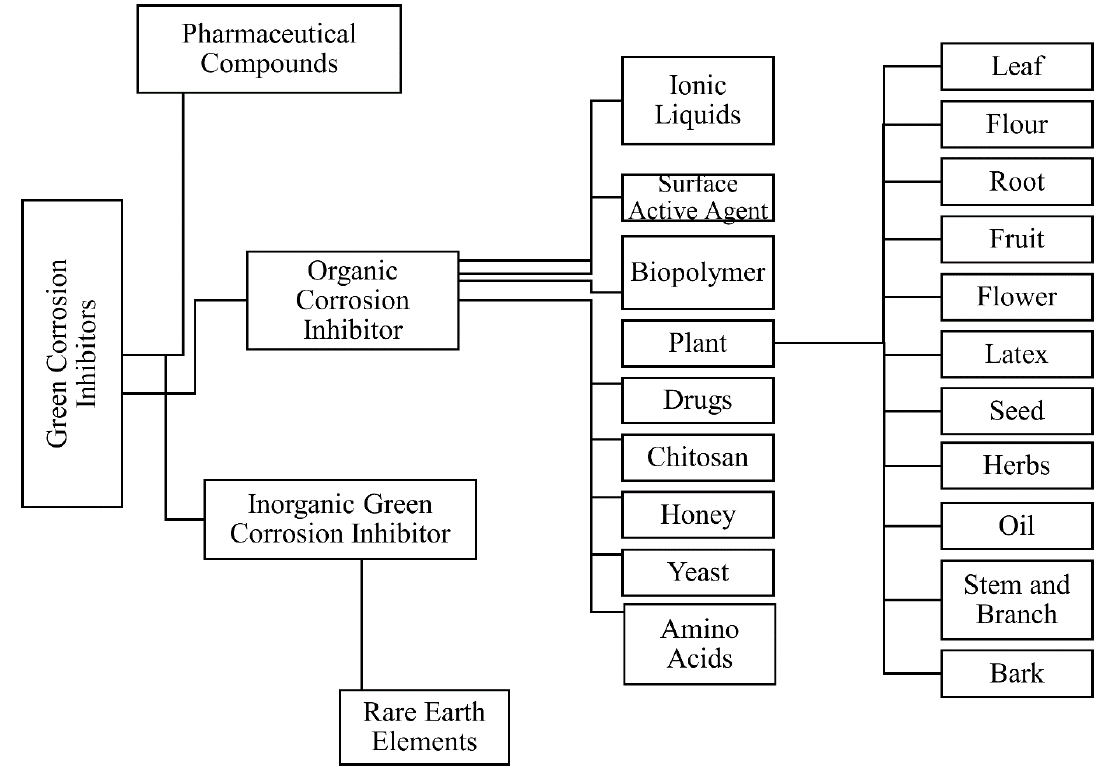
Figure 5. Flowchart of various Green Corrosion Inhibitors.